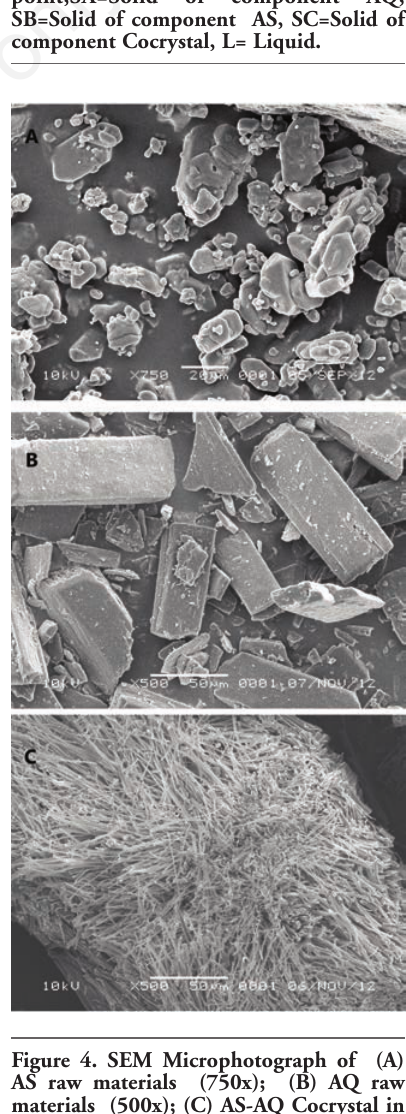
Figure 4. SEM Microphotograph of (A) AS raw materials (750x); (B) AQ raw materials (500x); (C) AS-AQ Cocrystal in methanol solvent